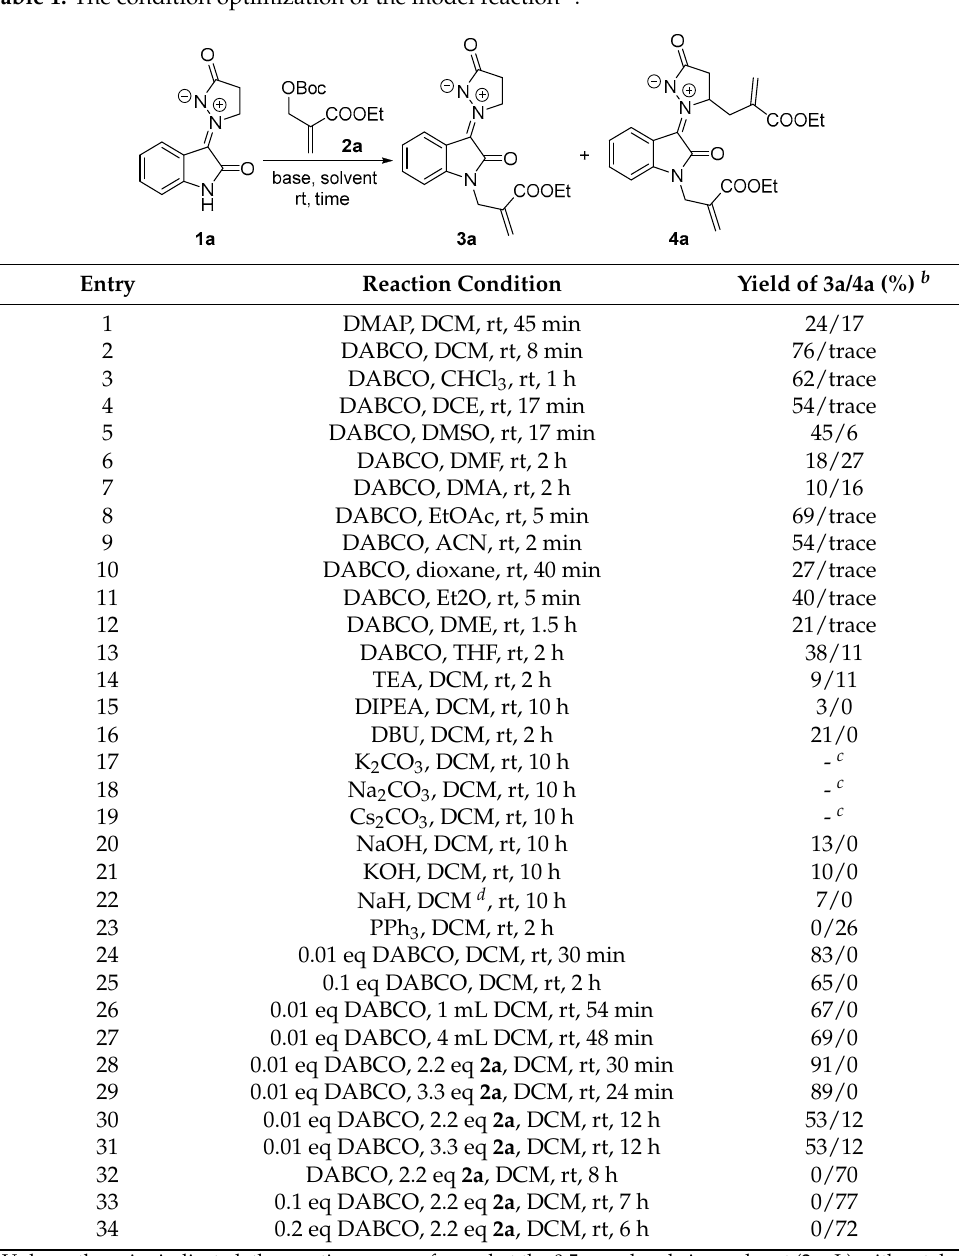
Table 1. The condition optimization of the model reaction a .